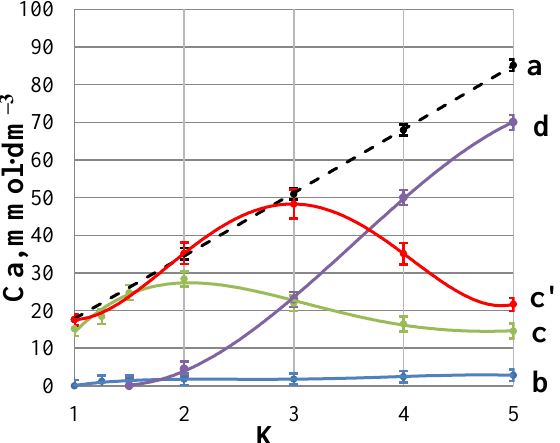
Figure 6. Variation of Ca 2 + concentration in a Blank C (a,b,c,d) and in GSI experiment (c’): (a) total calcium concentration in retentate + membrane; (b) Ca 2 + concentration in permeate; (c,c’) “free” calcium in retentate; and (d) calcium content on membrane surface as gypsum, expressed in units of calcium concentration.